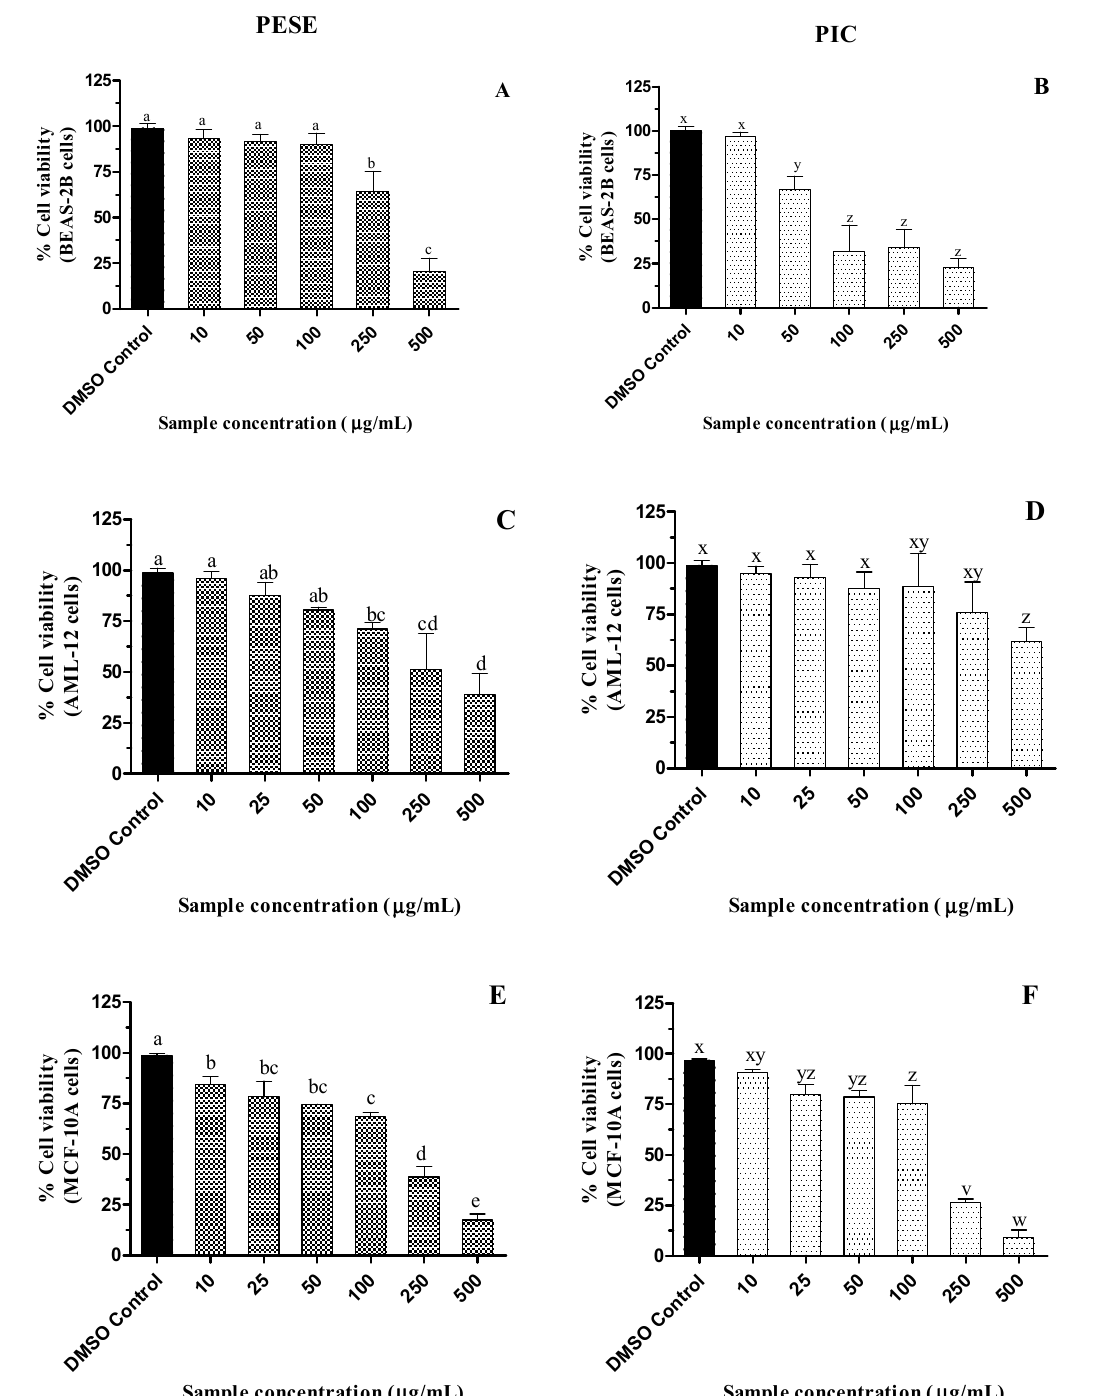
Figure 2. ( A – F ). Dose-dependent effect of ethanolic extract of passion fruit seeds on the viability of BEAS-2B, AML-12, and MCF-10A cell lines after 24 h of incubation. All the treatment groups were compared to dimethyl sulfoxide (DMSO) control. a–e, v–z, mean ± SD followed by different letters represent significant differences (ANOVA analysis was performed followed by the Tukey test, p ≤ 0.05). Data are means of triplicates. Abbreviation: AML-12, alpha mouse liver 12; BEAS-2B, normal human bronchial epithelial cells; MCF-10A, non-tumorigenic epithelial cells; DMSO, dimethylsulfoxide; PESE, ethanolic extract of P. edulis seeds; PIC, piceatannol.